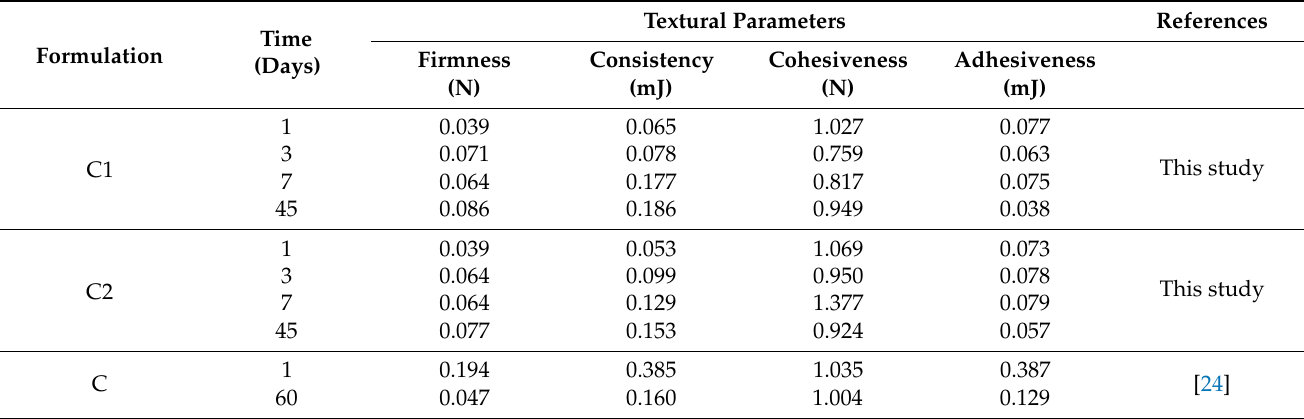
Table 3. Numerical values of the textural parameters for formulations C1 and C2 during the storage period at room temperature. Data obtained under the same manufacturing and scale